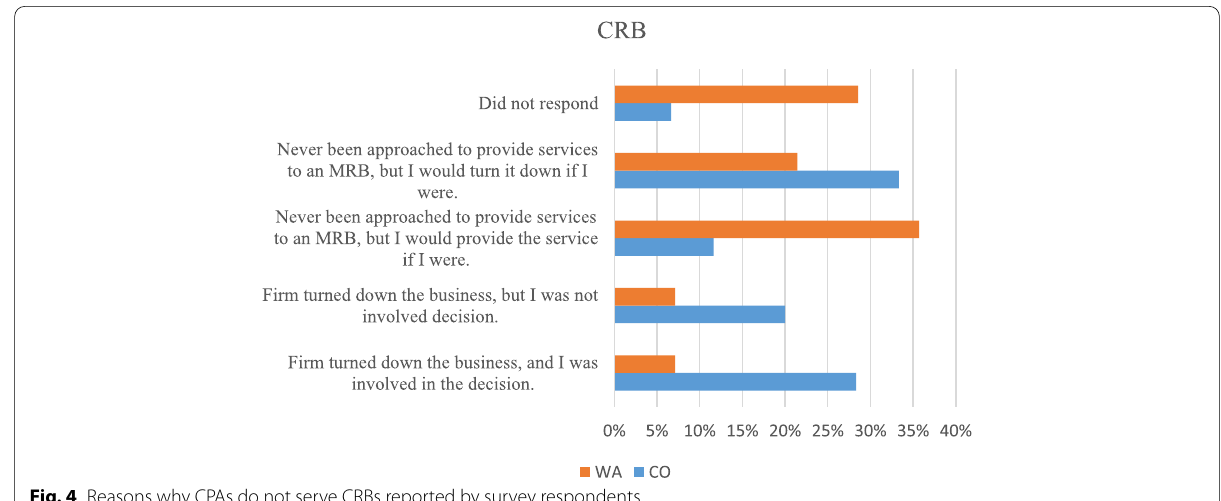
Fig. 4 Reasons why CPAs do not serve CRBs reported by survey respondents